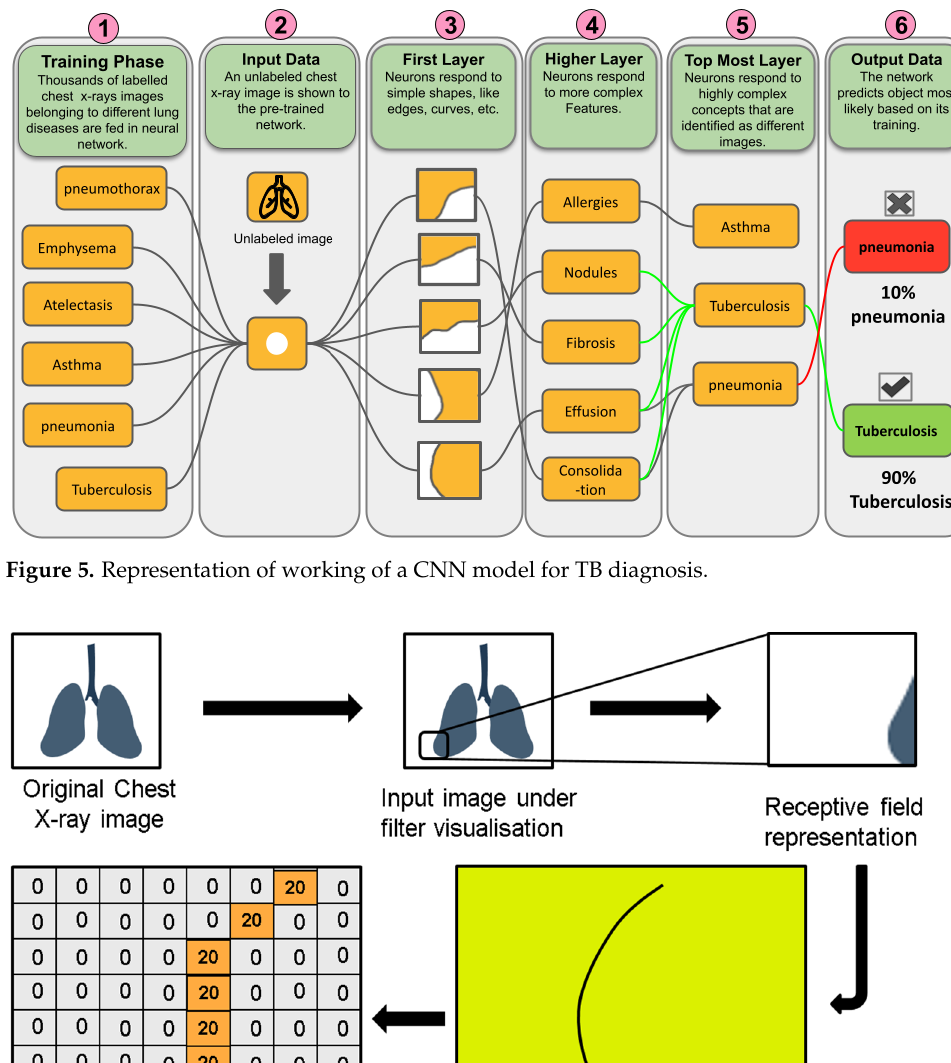
Figure 5. Representation of working of a CNN model for TB diagnosis.